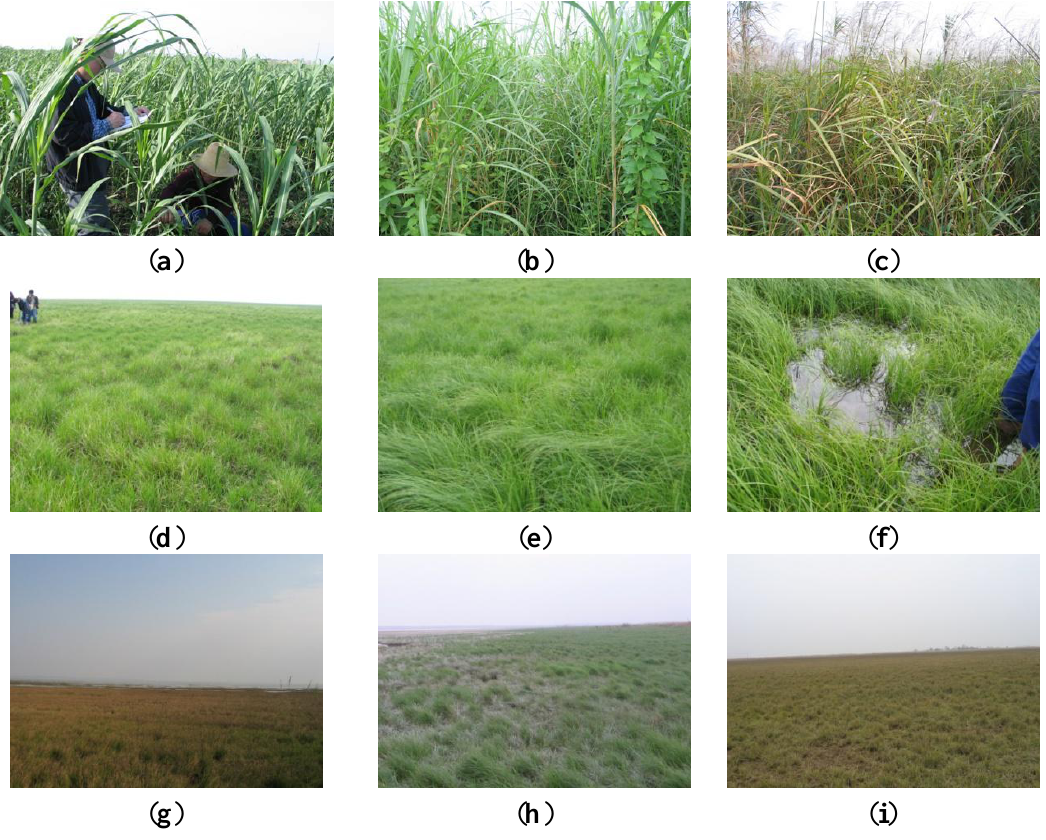
Figure 3. Phragmites communis collected on 20 April ( a ); 25 May ( b ); and 18 October ( c ); and Carex spp . on 28 March ( d ); 15 April ( e ); 25 May ( f ); 18 October ( g ); 26 November ( h ); and 29 December ( i ) in 2005 from the study